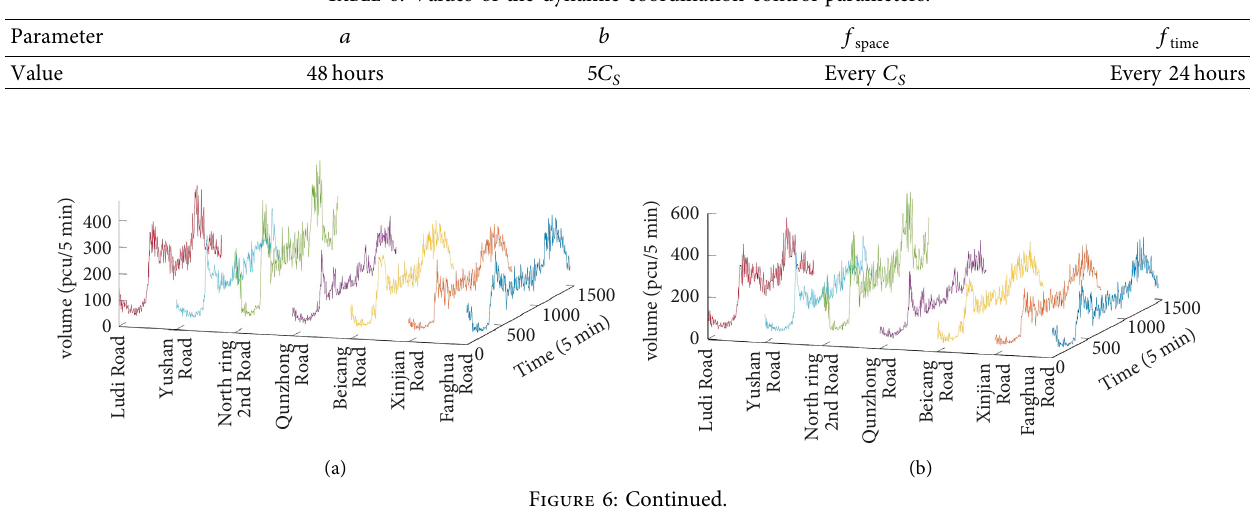
Table 6: Values of the dynamic coordination control parameters.